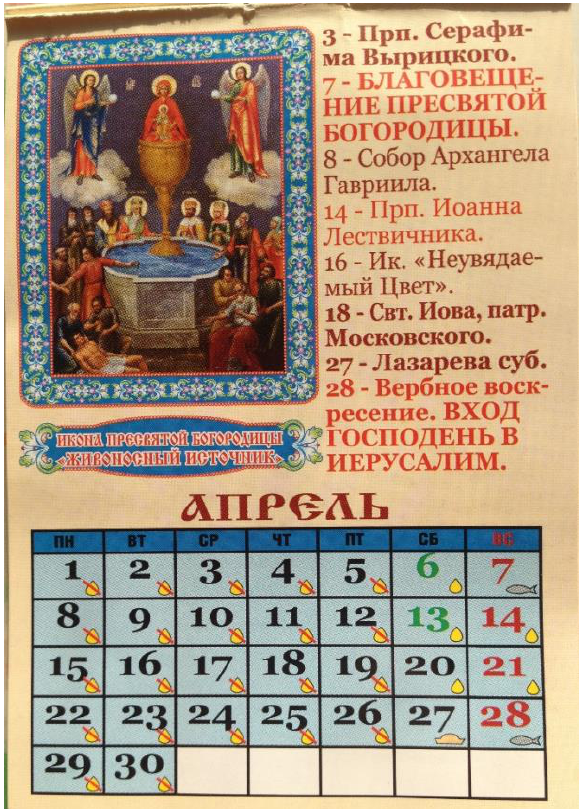
Figure 1. Orthodox handheld calendar for April 2013 (the Great Lent) composed in accordance with the Typikon. Yellow drops crossed out mean fasting from oil; a “bowl” on April 27 indicates that dairy products and fish eggs are allowed (the Saturday of St Lazar).